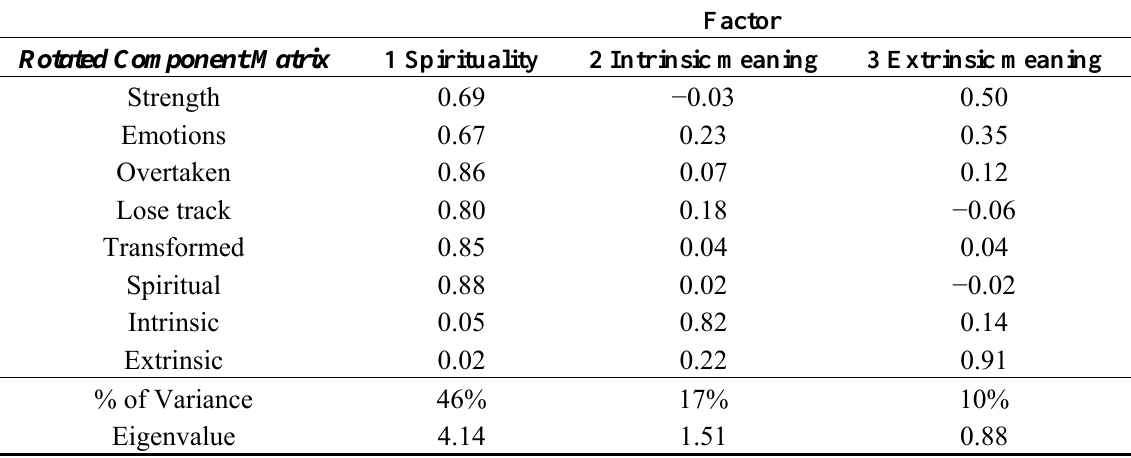
Table 2. Factor analysis of the religious